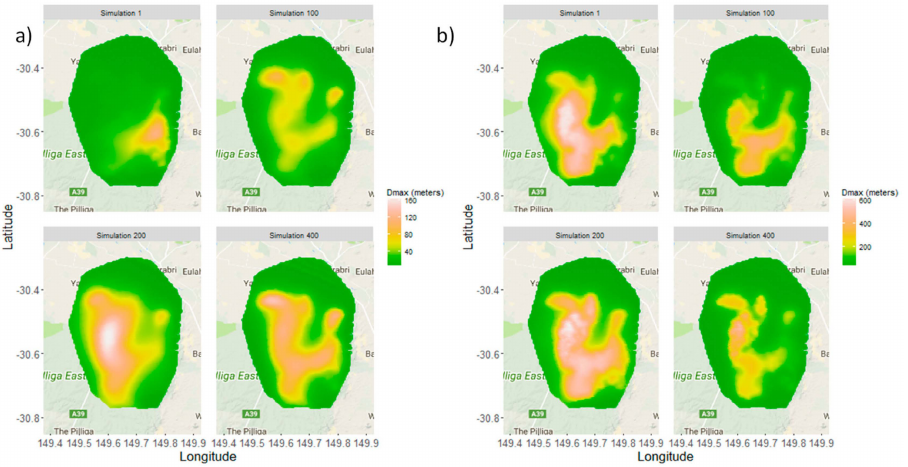
Figure 5. Four examples of simulated D-max in ( a ) model layer 8 and ( b ) model layer 12.